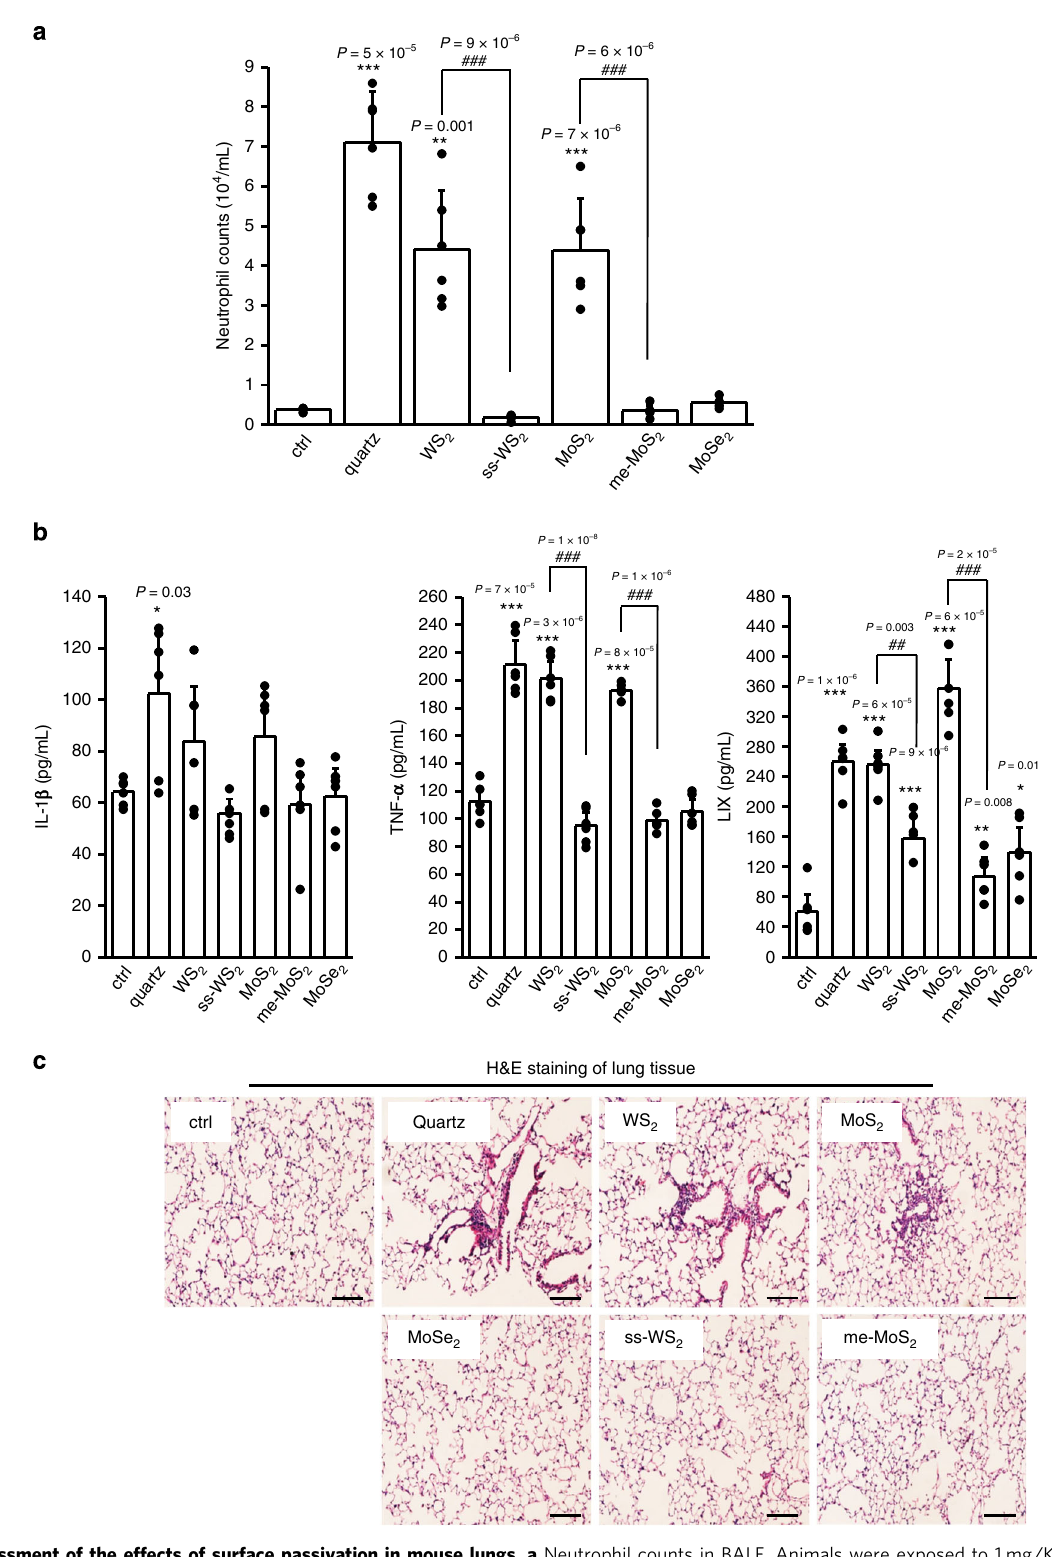
Fig. 7 Assessment of the effects of surface passivation in mouse lungs. a Neutrophil counts in BALF. Animals were exposed to 1 mg/Kg pristine or surface modi fi ed TMDs by oropharyngeal aspiration ( n = 6 mice). After 40 h, the animals were sacri fi ced and alveolar macrophages in BALF of mouse lungs were collected for overnight incubation. Immune cells in BALF were concentrated on glass slides by cytospin, fi xed and stained by Quick-Diff for cell counting. Neutrophil count data are presented as mean values ± SD. b Pro-in fl ammatory cytokine production in BALF and c representative H&E staining images of lung tissues from six biologically independent samples (scale bar: 100 μ m). Pro-in fl ammatory cytokines were determined by ELISA. Cytokine data are presented as mean values± SD. * p < 0.05, ** p < 0.01, *** p < 0.001 compared to vehicle controls, # p < 0.05, ## p < 0.01, ### p < 0.001 compared to WS 2 and MoS 2 by two-tailored Student t